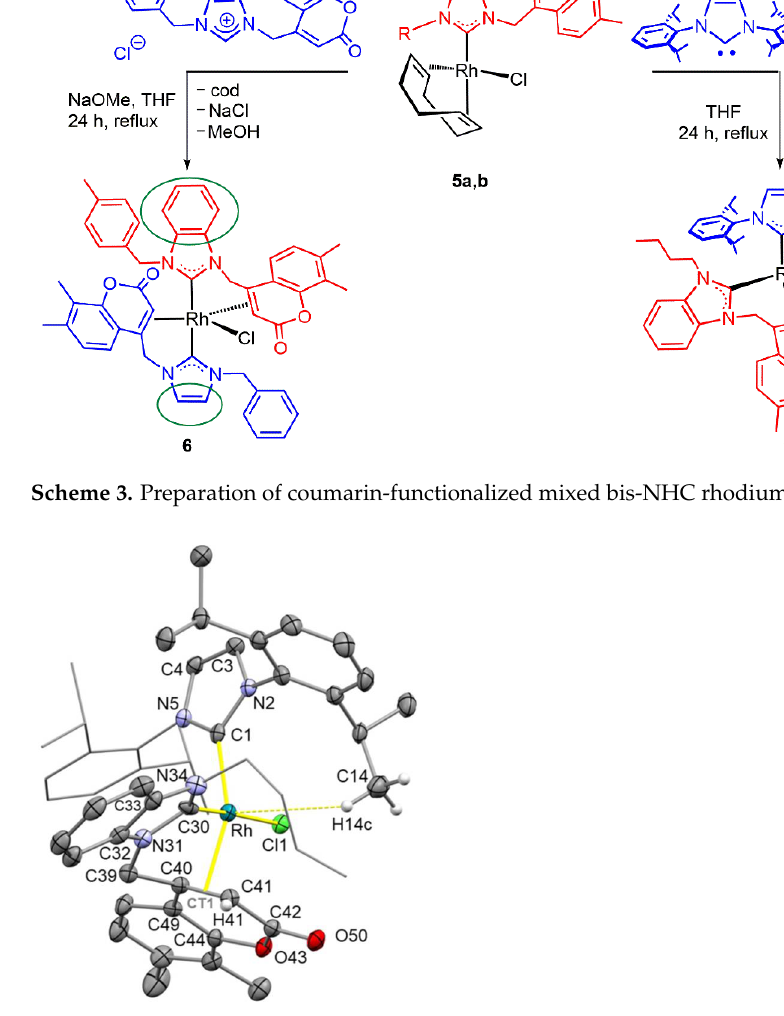
Figure 3. ORTEP view of 7 . For clarity, most hydrogen atoms are omitted and selected groups are shown in a wireframe style. Thermal ellipsoids are at 50% probability. Selected bond lengths (Å) and angles ( ◦ ) are: Rh-Cl1 2.4116(8), Rh-C1 2.070(3), Rh-C30 1.959(3), Rh-CT1 2.0294(3), C40-C41